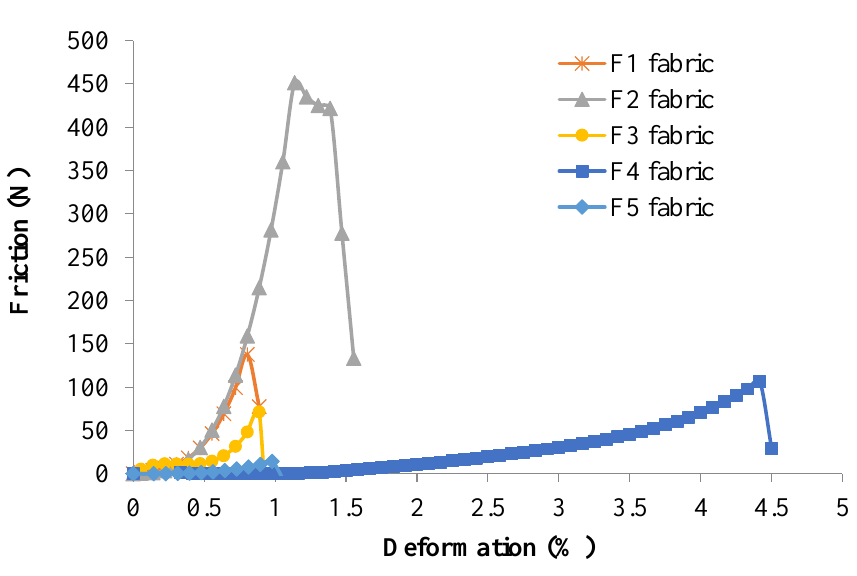
Figure 8. Average friction load–deformation of the binding warp yarns during the tensile tests of five di ff erent 3DWIFs samples.